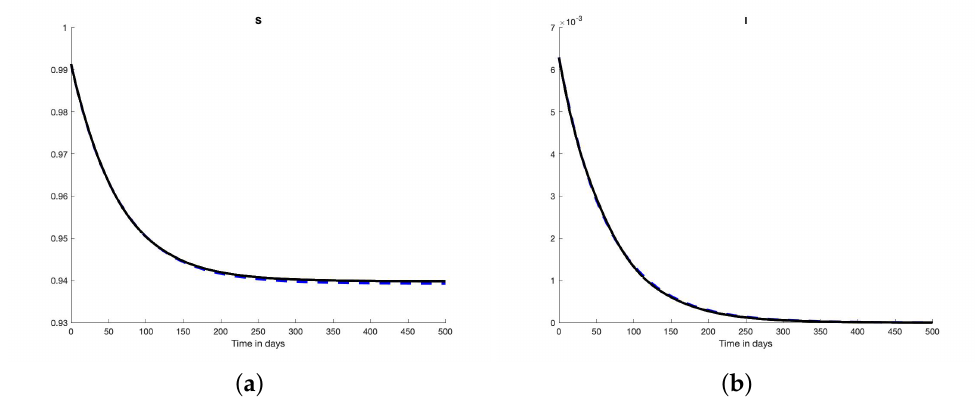
Figure 14. Scenario 6: States. ( a ) S and S ∗ (- -); ( b ) I and I ∗ (- -).